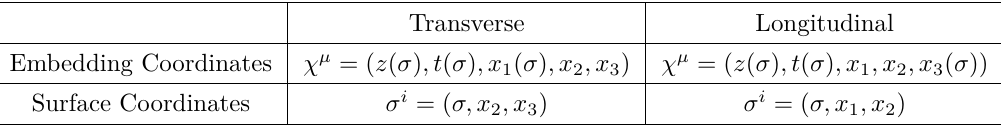
Table 1 . The coordinates we choose for the embedding of a surface anchored at the AdS conformal boundary.